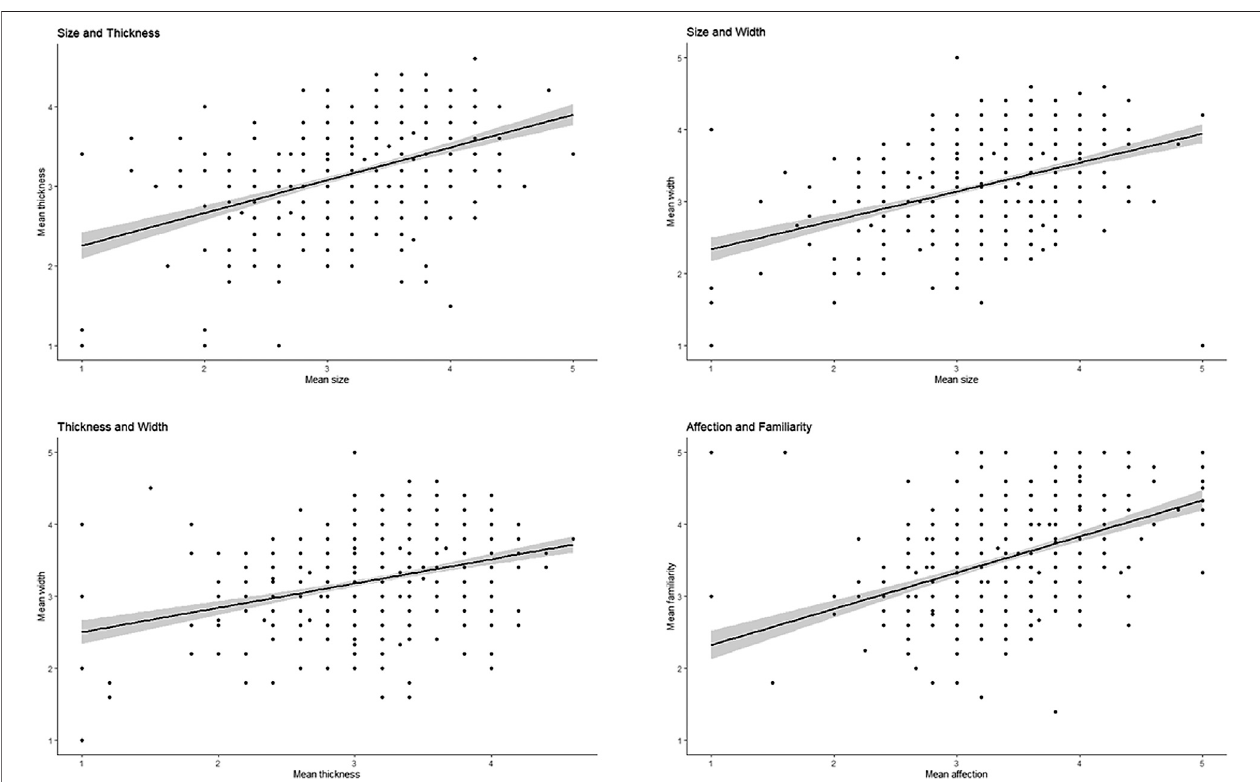
FIGURE 2 | Scatter plots for correlations between mean scores of subjective evaluations (r > 0.30). An upper left fi gure shows a correlation between size and thickness. An upper right fi gure shows a correlation between size and width. A lower left fi gure shows a correlation between thickness and width. A lower right fi gure shows a correlation between affection and